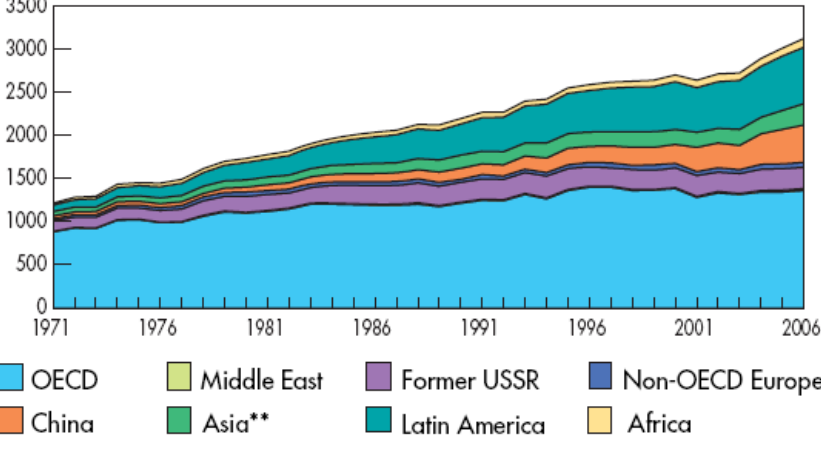
Figure 35. Evolution of hydro electricity production by region (after [17]). Asia excludes